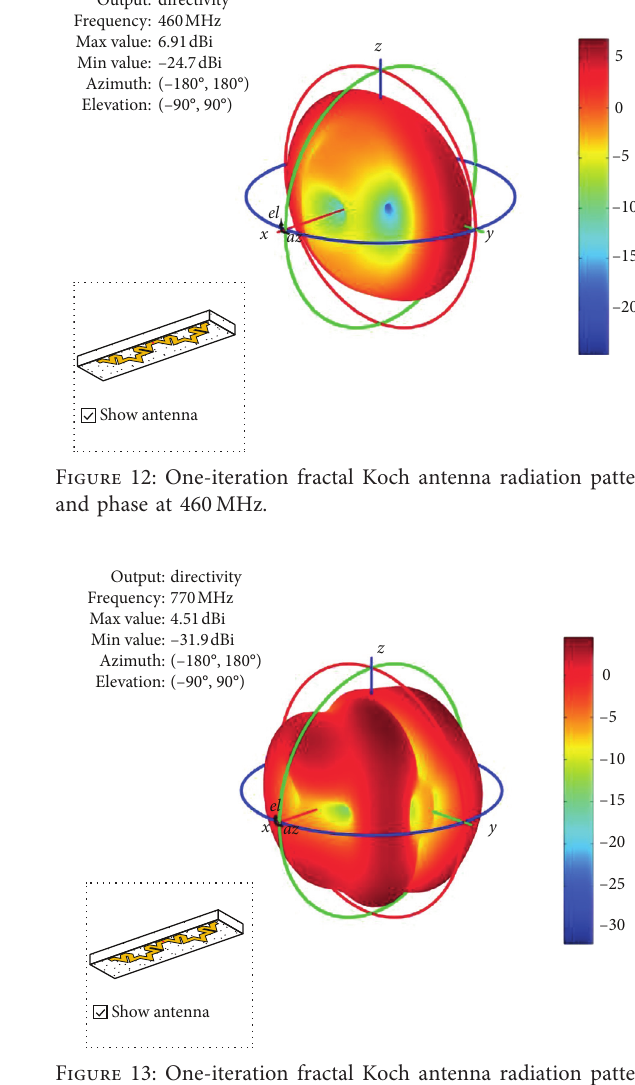
Figure 10: Fractal Koch antenna (iteration 1).